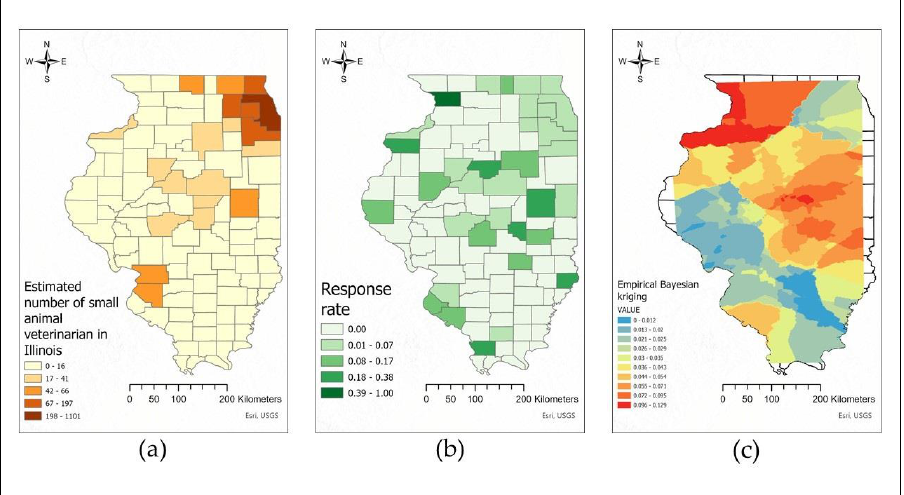
Figure 2. Choropleth map of the estimated number of small animal veterinarians in Illinois ( a ). Choropleth map of response rates of the survey on AMR and AMU practices among Illinois companion animal veterinarians ( b ). Isopleth map of the spatial interpolation of survey response rates by using empirical Bayesian kriging ( c ).